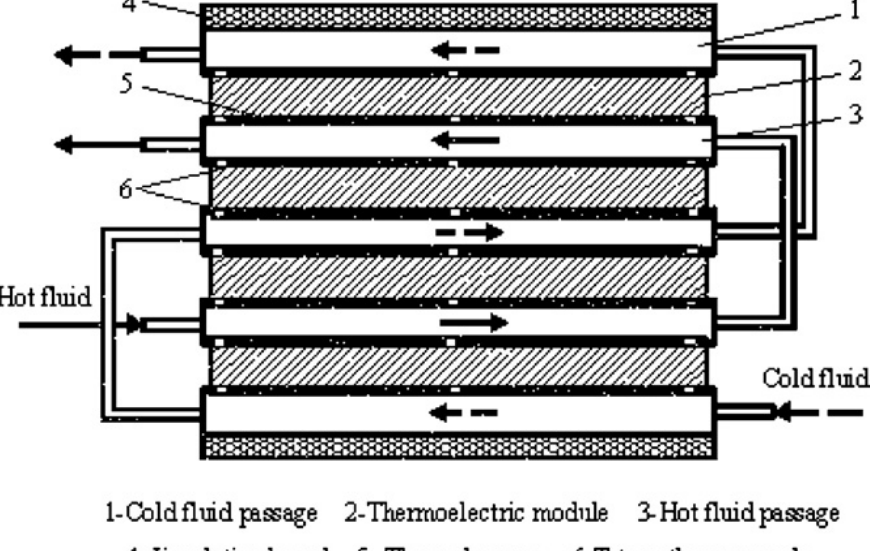
Figure 4. Experimental setup of the fluid-fluid TEG heat exchanger of Niu et al. [53]. Reprint with